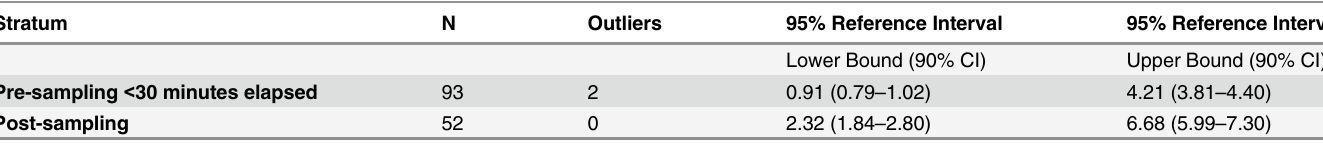
Table 3. Serum Cortisol Reference Intervals. Stratum